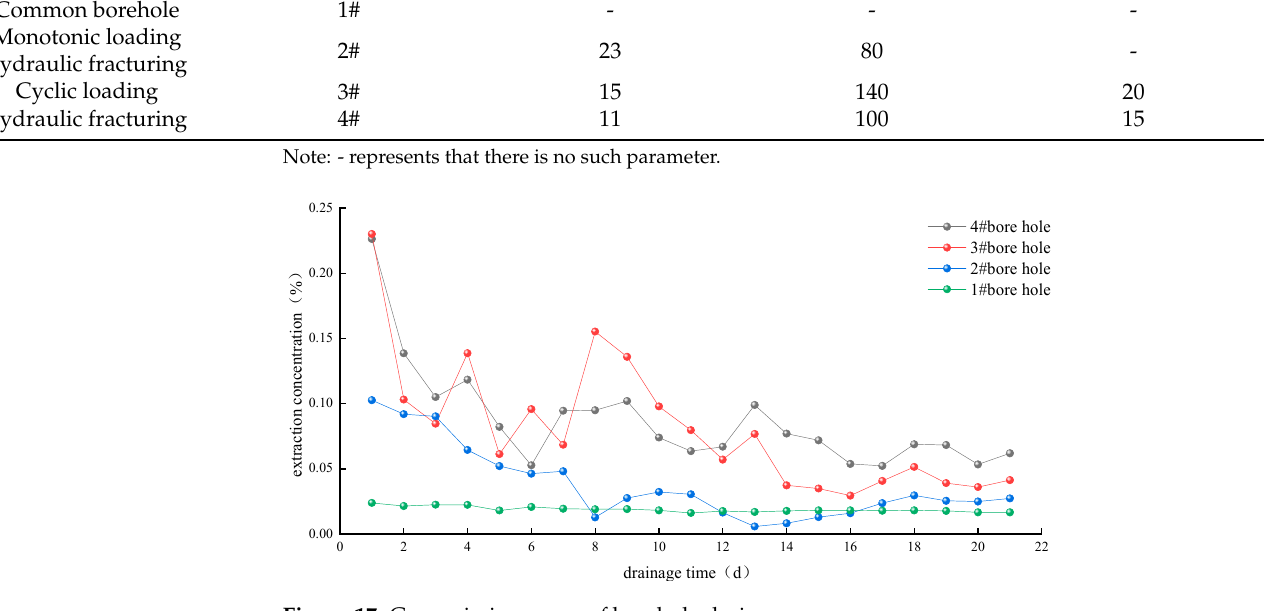
Figure 17. Gas emission curve of borehole drainage.